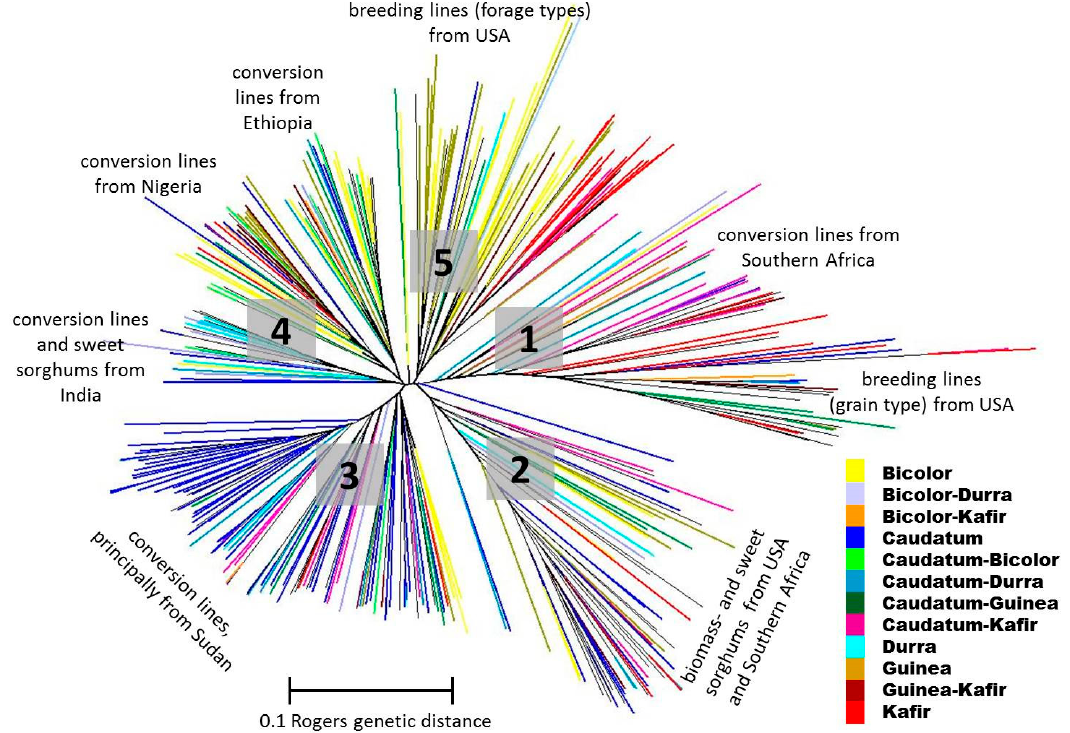
Figure 4. Phylogram displaying the genetic relatedness in the present sorghum diversity set ( n = 338) by the neighbor-joining method, showing that clustering in groups is predominantly based on geographic origin and